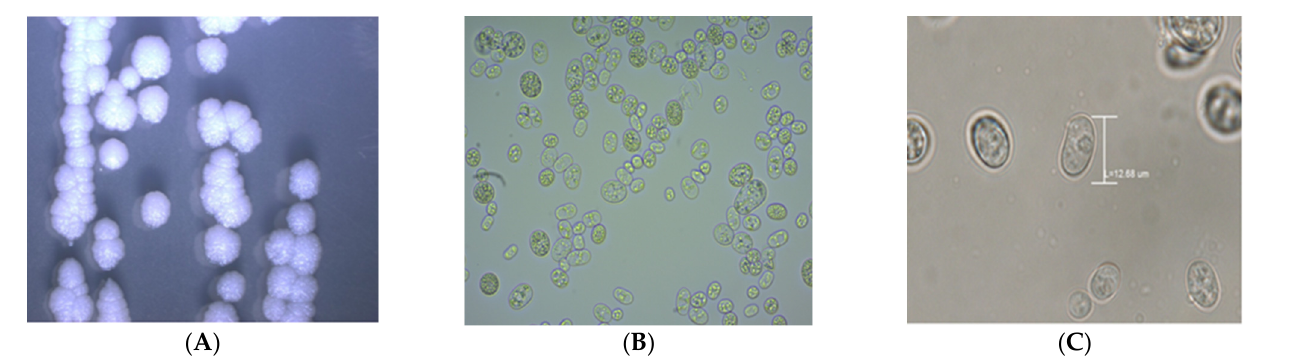
Figure 2. Morphology of Prototheca bovis with a light microscope. From left to right: ( A ). Colonies on SDA at 10× magnification. ( B ). A wet mount preparation of Prototheca cells at 40× magnification. Some cells show a small amount of green pigment. ( C ). P. bovis at 100× magnification. The cells have a diameter of about 12 μ m with a thick cell wall and a poorly distinguishable nucleus. The presence of sporangia can be observed. The preparations were photographed using a digital camera (Olympus, Tokyo, Japan) adapted to the light microscope.